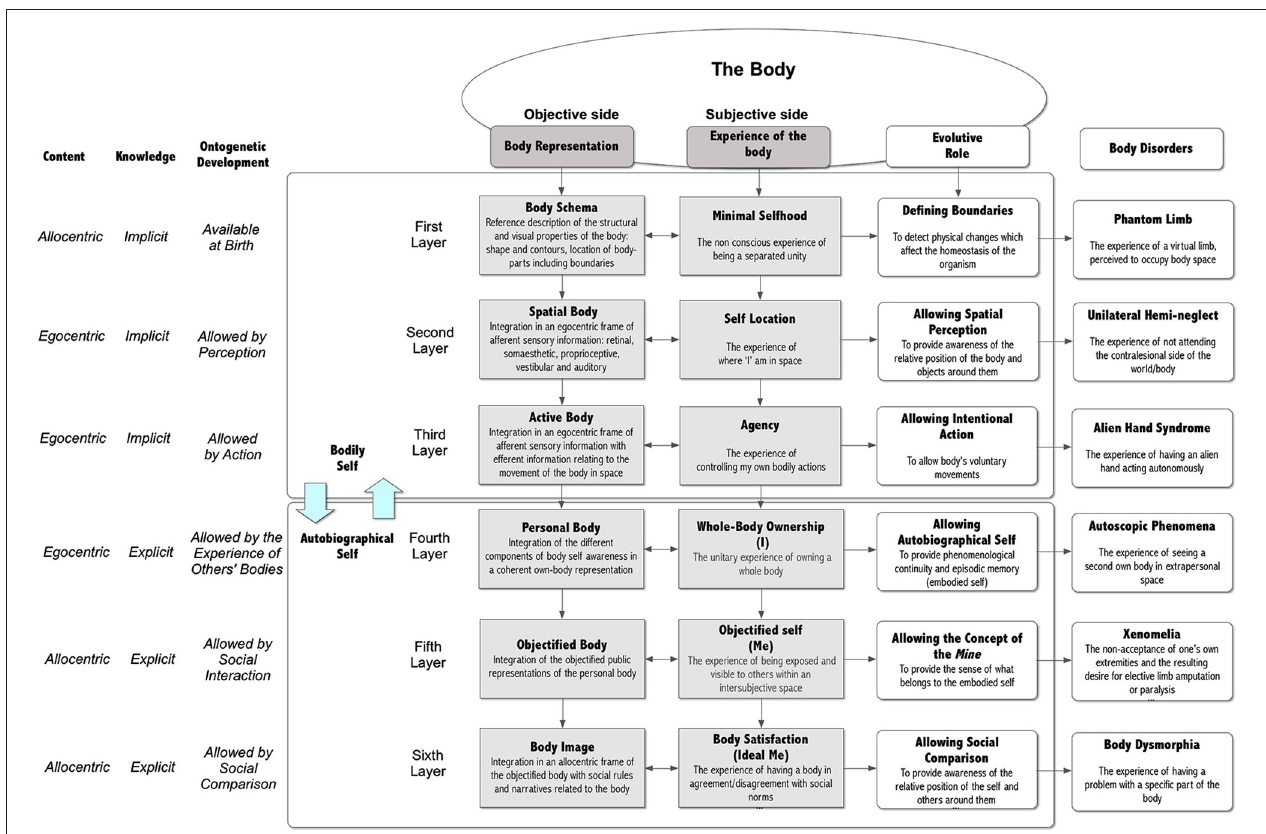
FIGURE 1 | Bodily self-consciousness and related disorders